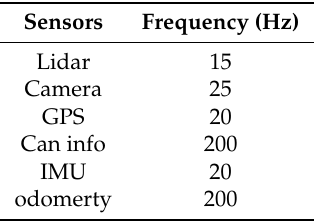
Table 10. The details of sensors operating